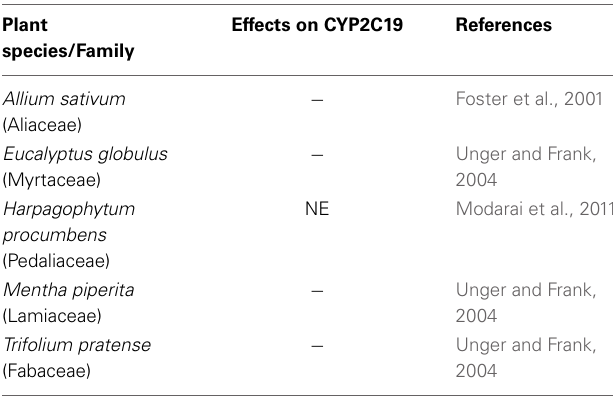
Table 3 | Medicinal plant species listed in RENISUS with reported effects of on CYP2C19.